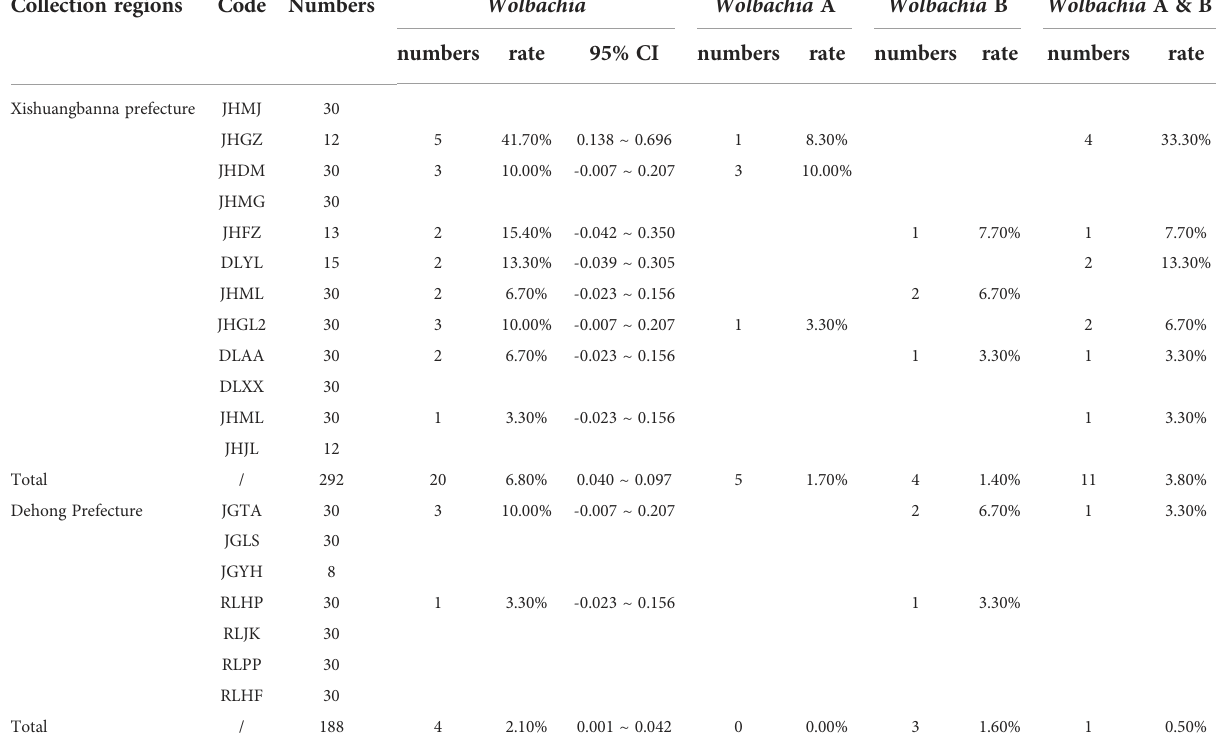
TABLE 3 Infection of Ae. aegypti with Wolbachia in Yunnan Province.